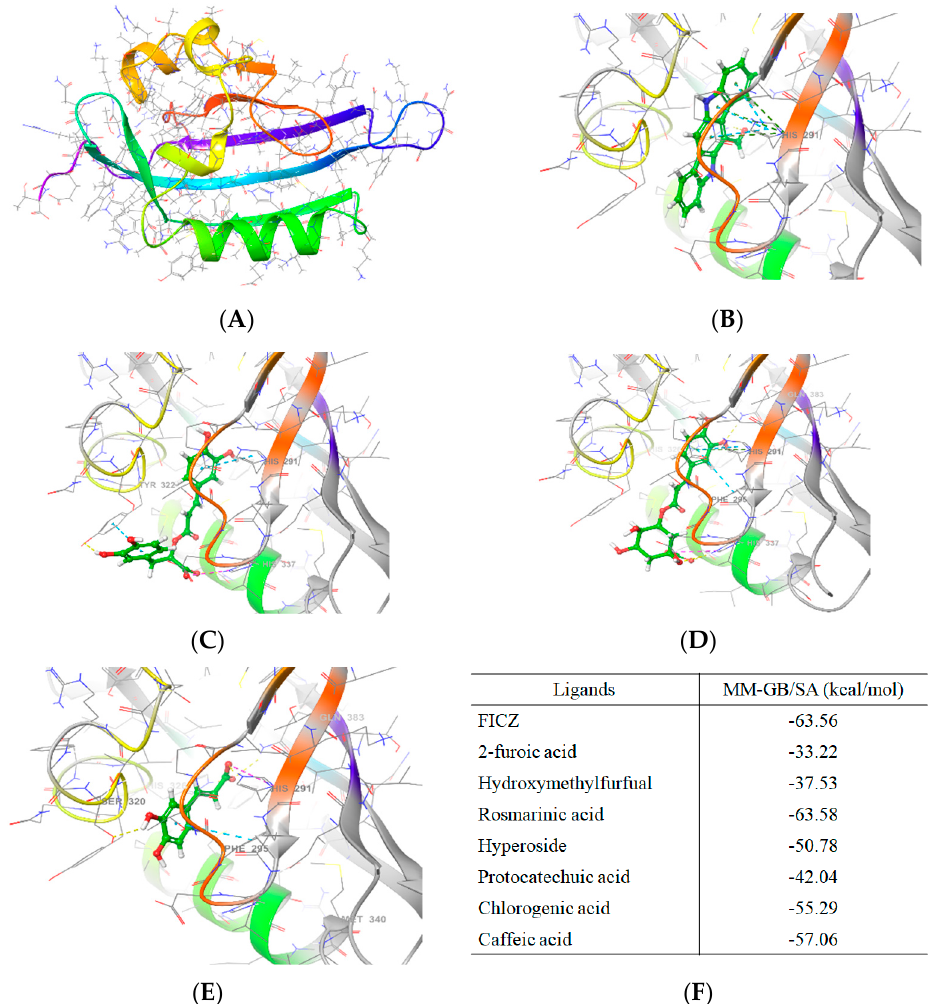
Figure 7. Predicted binding poses and MM-GB/SA values by the molecular docking simulation. ACTPER contains chemical compounds predicted to bind to AhR when analyzed by a molecular docking simulation. ( A ) Crystal structure of AhR-LBD. 2D AhR-LBD interaction diagram in complex with ( B ) FICZ, ( C ) rosmarinic acid, ( D ) chlorogenic acid and ( E ) caffeic acid; ( F ) MM-GBSA binding free energy values. The more negative MM-GBSA value indicates stronger binding.